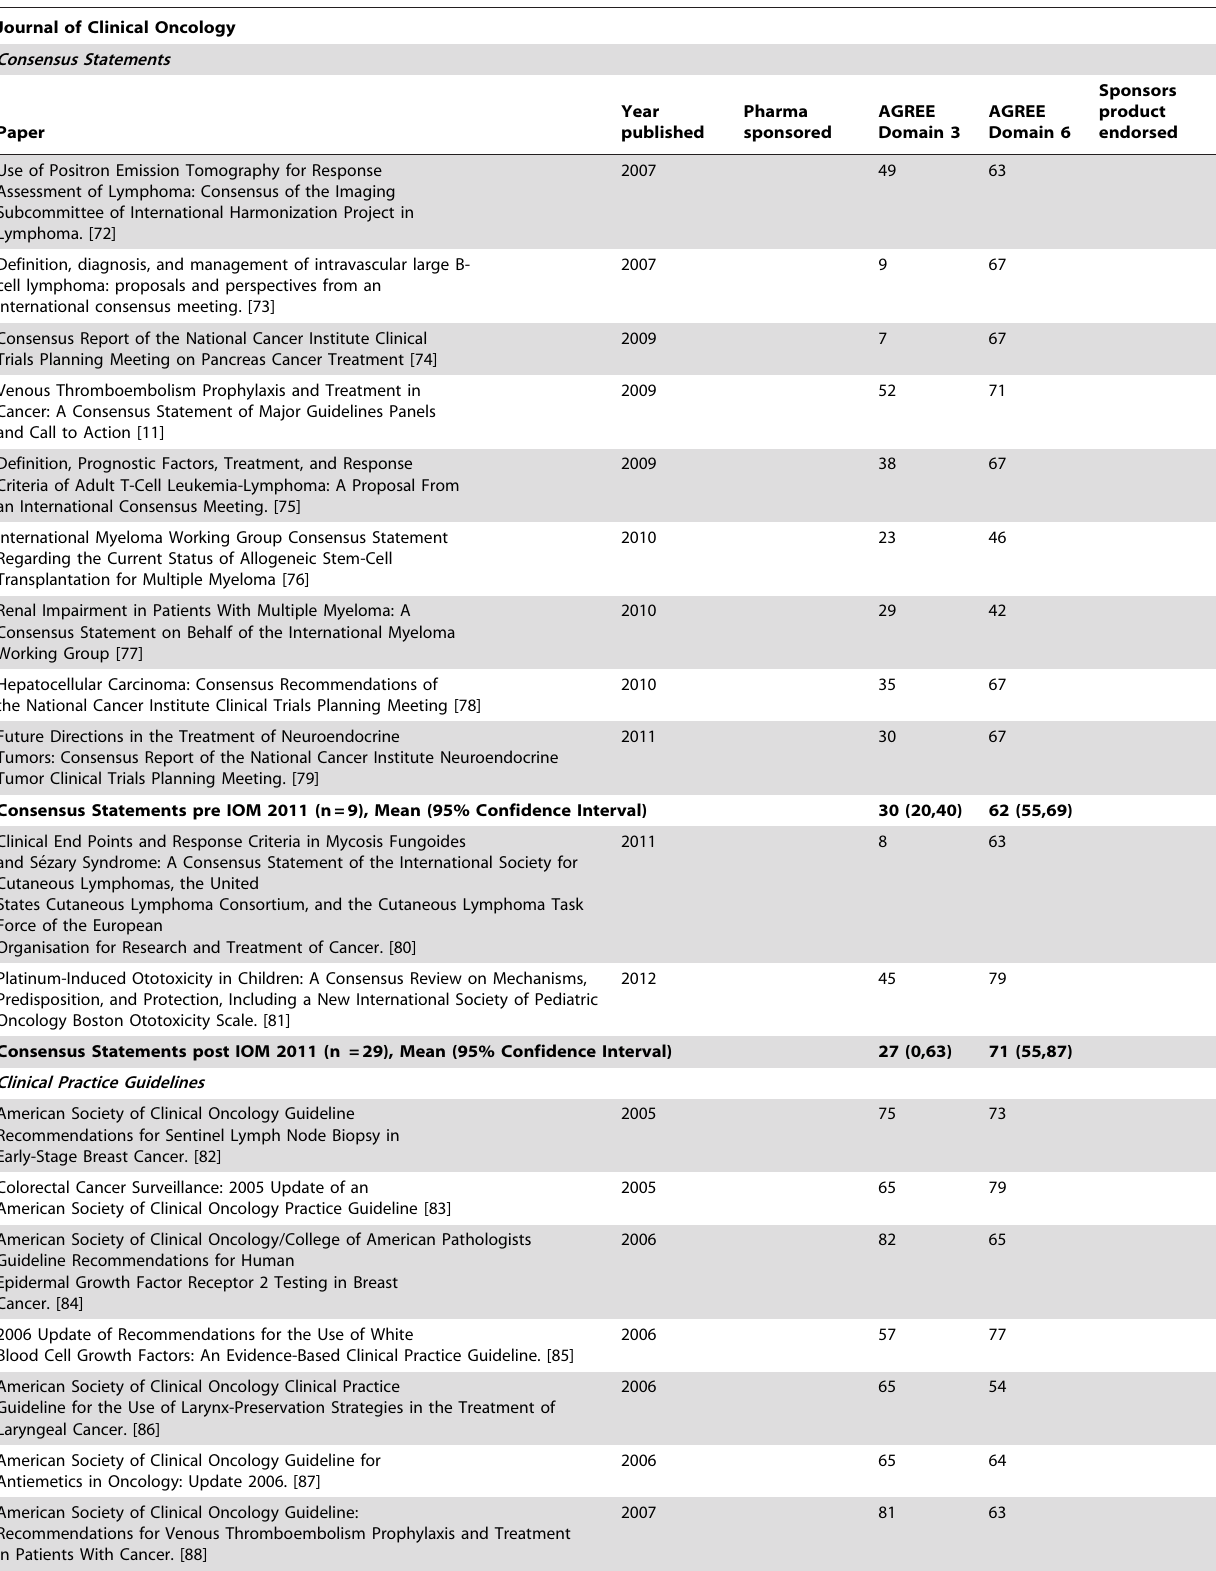
Table 6. Journal of Clinical Oncology Consensus Statements and Clinical Practice